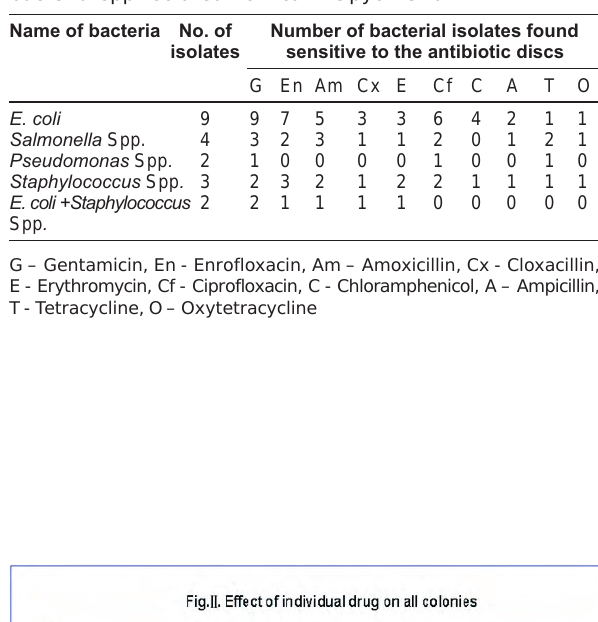
Table-3. Antibiotic sensitivity and resistance profiles of bacterial spp. isolated from canine